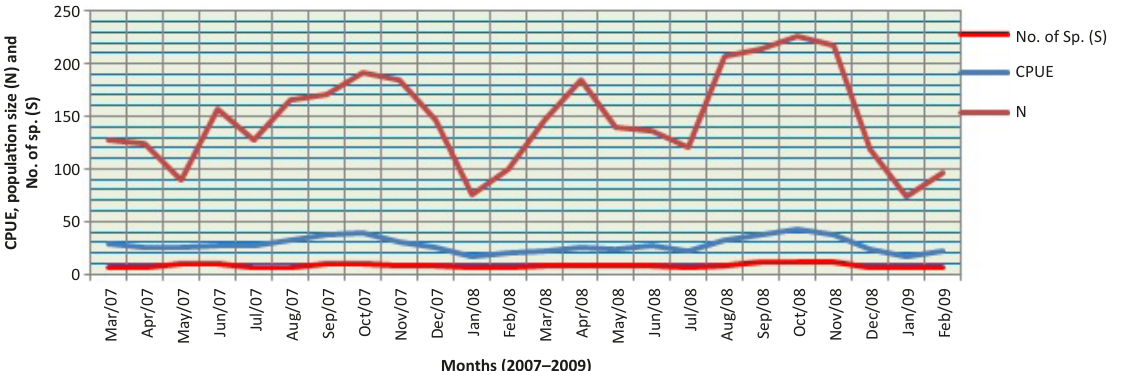
Figure 2. Graph showing the monthly variations of CPUE, population size (N) and number of species (S) of ichthyofauna in the hill stream